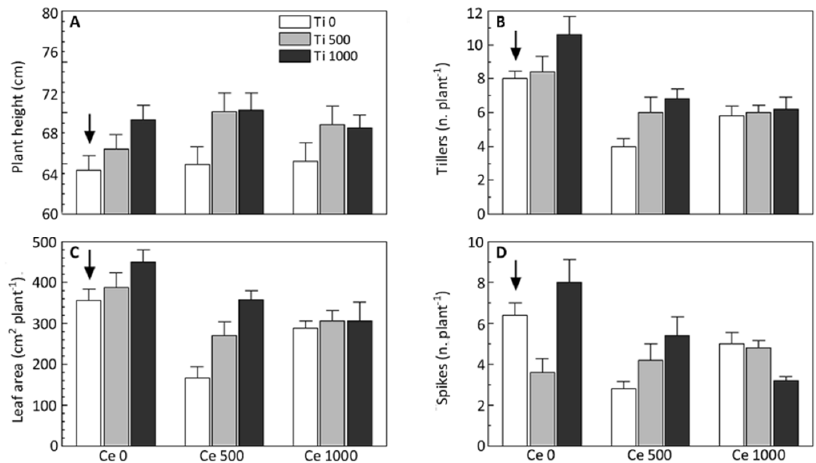
Figure 2. Plant height ( A ); number of tillers ( B ); leaf area ( C ) and number of spikes ( D ) observed in plants of barley grown in control soil and n CeO 2 and n TiO 2 -amended soil. Bars are mean standard error ( n = 5). Arrows indicate the control.